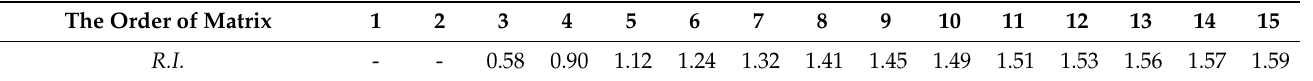
Table 2. Random indexes ( R.I.